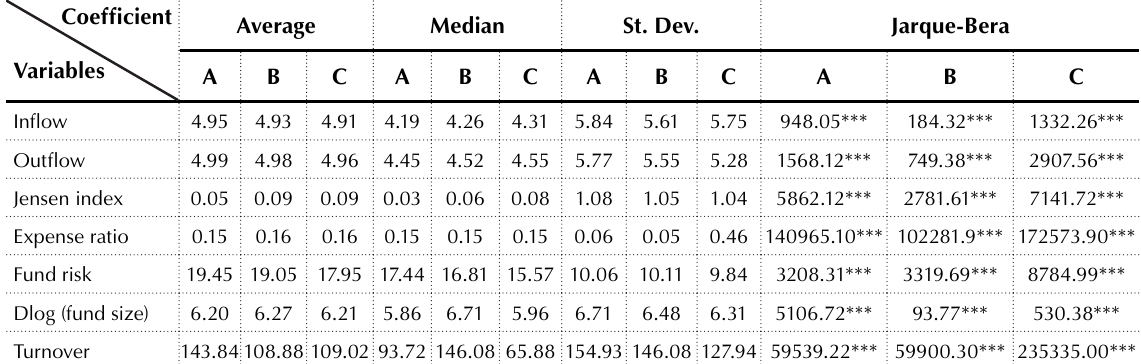
Table 10. Fund Jarque-Bera table